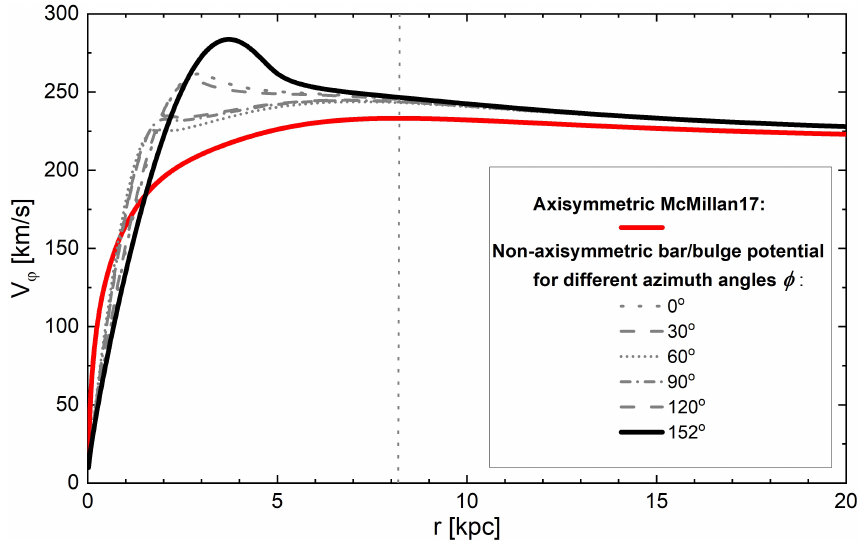
Figure 3. Rotation curves for axisymmetric McMillan17 (red line) and for a non-axisymmetric model with the bar for different orientations (black lines). Angle of 152 ◦ corresponds to the direction along the major axis of the